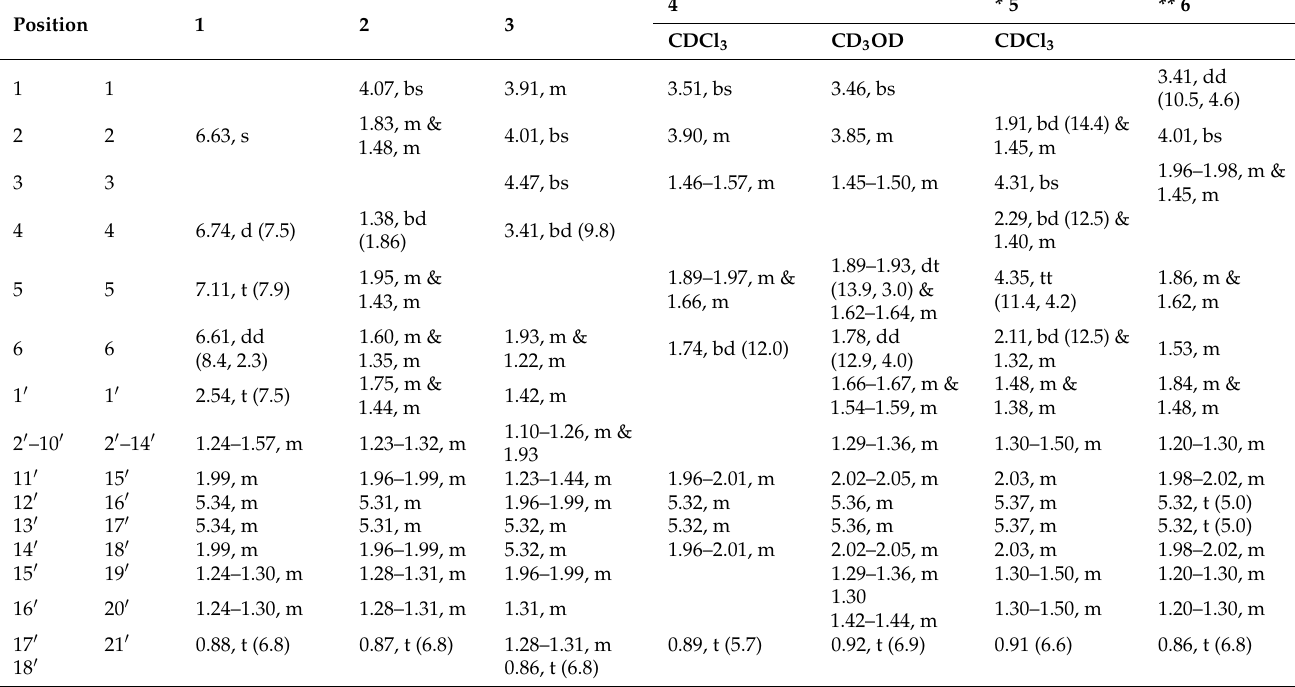
Table 2. 1 H NMR [400 MHz, δ H , mult. ( J in Hz)] spectral data for compounds 1–4 isolated from H. caffrum gum and 5 and 6 , structurally similar to 4